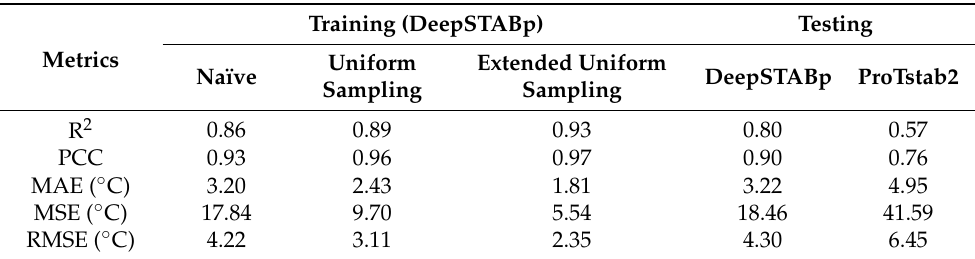
Table 1. Assessment of model performance during model training and testing. During training, we monitored model performance with respect to different sampling strategies used during dataset assembly. With “extended uniform sampling” yielding the best results, we built DeepSTABp and evaluated its performance in direct comparison to